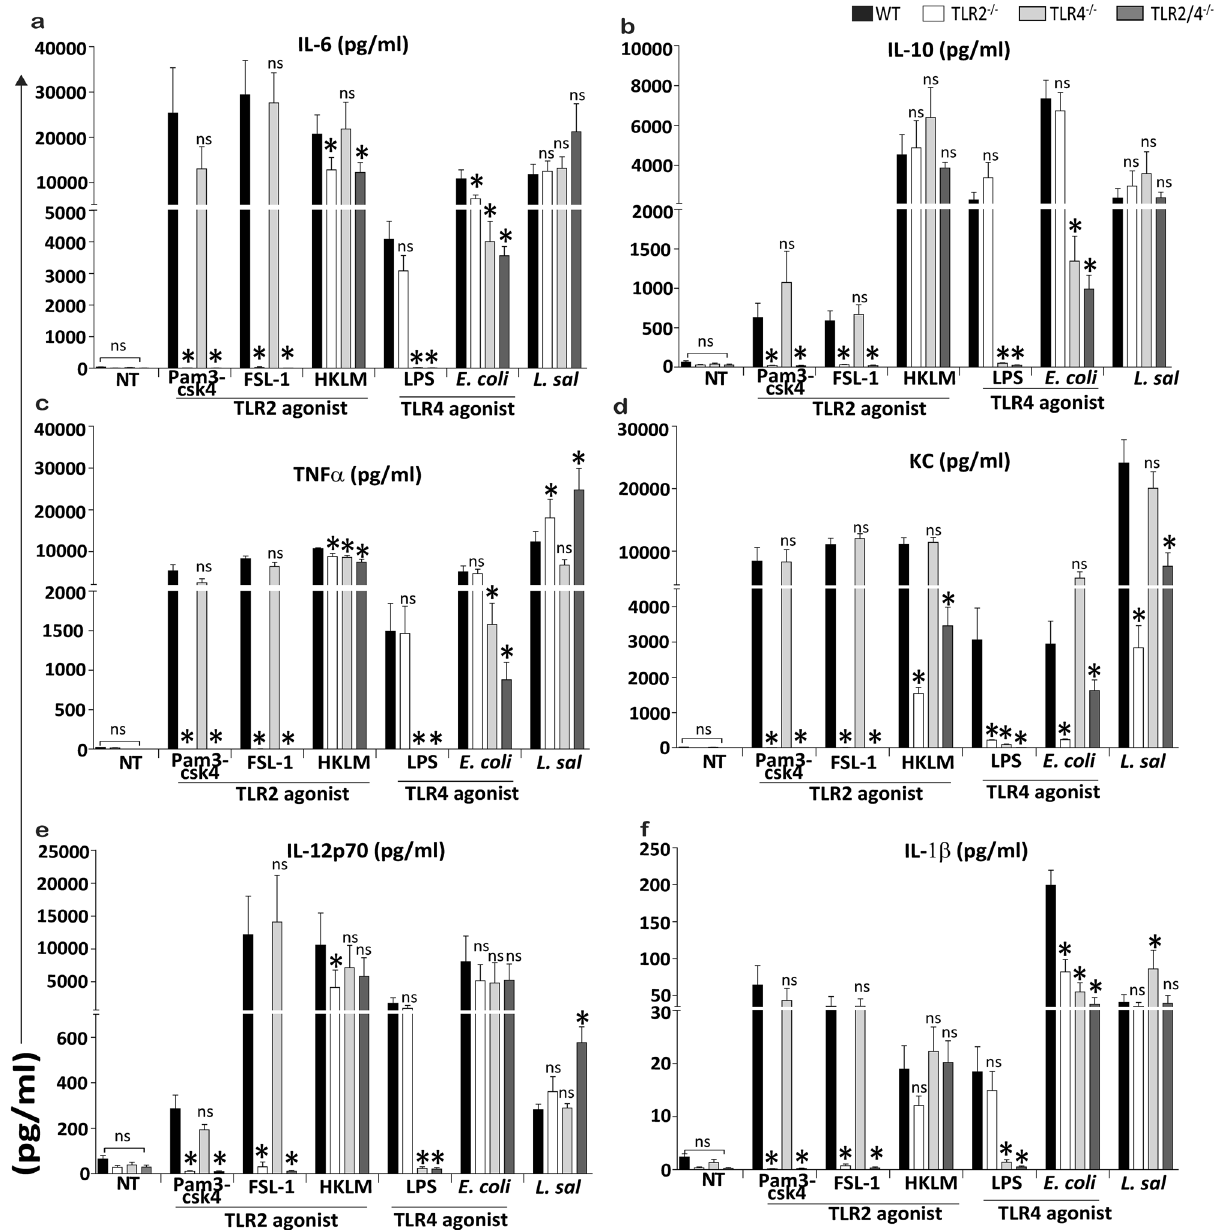
Figure 4. L. salivarius induced cytokine responses are TLR4 independent in murine BMDMs. ( a ) Il-6, ( b ) Il-10, ( c ) TNF-α, ( d ) KC, ( e ) Il-12p70 and ( f ) Il1-β cytokine secretion (pg/ml) was quantified by MSD-7 plex from WT and TLR2 −/− , TLR4 −/− , TLR2/4 −/− BMDMs that were non treated (NT) or treated with TLR2 agonist (HKLM- heat-killed Listeria monocytogenes ), TLR1/2 agonist (Pam3csk4), TLR2/6 agonist (FSL-1), TLR4 agonist (LPS- B5 from E. coli B5) or co-cultured with E. coli and L. salivarius UCC118 at MOI of 10 for 20 h. Data shown are the average of triplicate of three independent experiments (n = 3). Cytokine response triggered by TLR2 −/− , TLR4 −/− and TLR2/4 −/− BMDMs were compared relative to the cytokine response triggered by WT BMDMs. Statistical analysis was performed with 2 tailed student t test in GraphPad Prism, p < 0.05 (denoted by *) was considered statistically significant. ns confirmed by RT-qPCR (Fig. 8a). Heat-killed Mycobacterium tuberculosis (HKMT), a reported Mincle and TLR2 agonist 45,46 , was used a positive control for TNF-α response triggered by Clec4e /Mincle in BMDMs. TNF-α response to HKMT was reduced in Clec4e −/− macrophages as expected (Fig. 8b). TNF-α responses triggered by L. salivarius UCC118 were also partially reduced in Clec4e −/− BMDMs in comparison to BMDMs from co-housed WT littermates (Fig. 8b). LPS (TLR4 agonist) and B. breve showed no difference in TNF-α responses between WT and Clec4e − / − BMDMs (Fig. 8b). Interestingly, FSL1 (TLR2 agonist) also had reduced TNF-α responses in Clec4e −/− BMDMs (Fig. 8b), suggesting a possible role for Mincle in the regulation of TLR2 induced cytokine